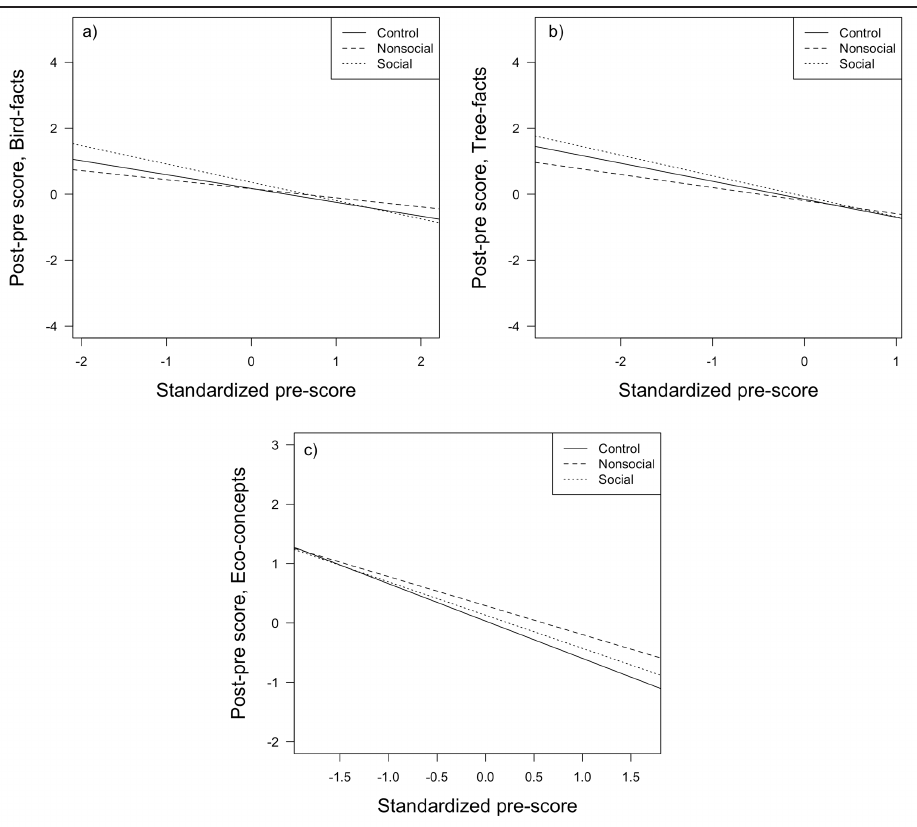
Figure 5: Linear regression lines for the relationship between pre-test score and post-pre-test difference. R 2 values ranged from 0.11 to 0.75 and were lowest for birds and highest for ecological